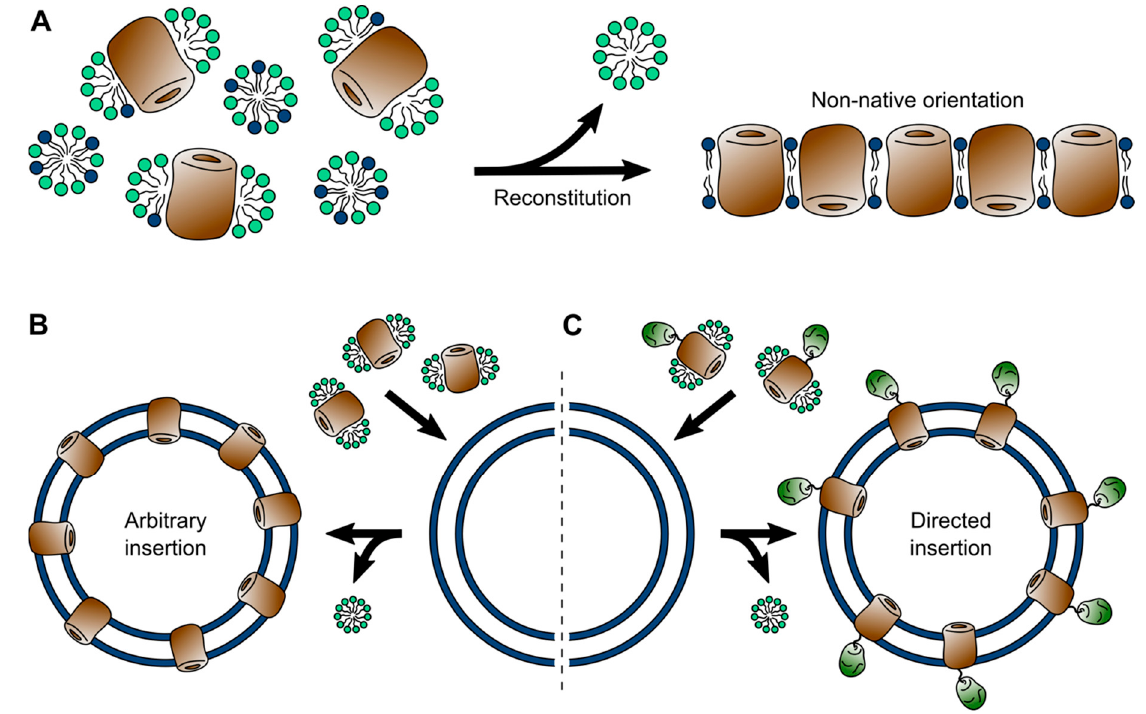
Figure 3. Reconstitution of membrane proteins into liposomes. ( A ) Bottom-up assembly from a ternary mixture (left), driven by detergent removal, typically results in an alternating up-down orientation of membrane proteins (right). ( B ) Undirected insertion of membrane proteins into preformed liposomes. ( C ) Directed insertion of membrane proteins into preformed liposomes with soluble domains facing outwards.